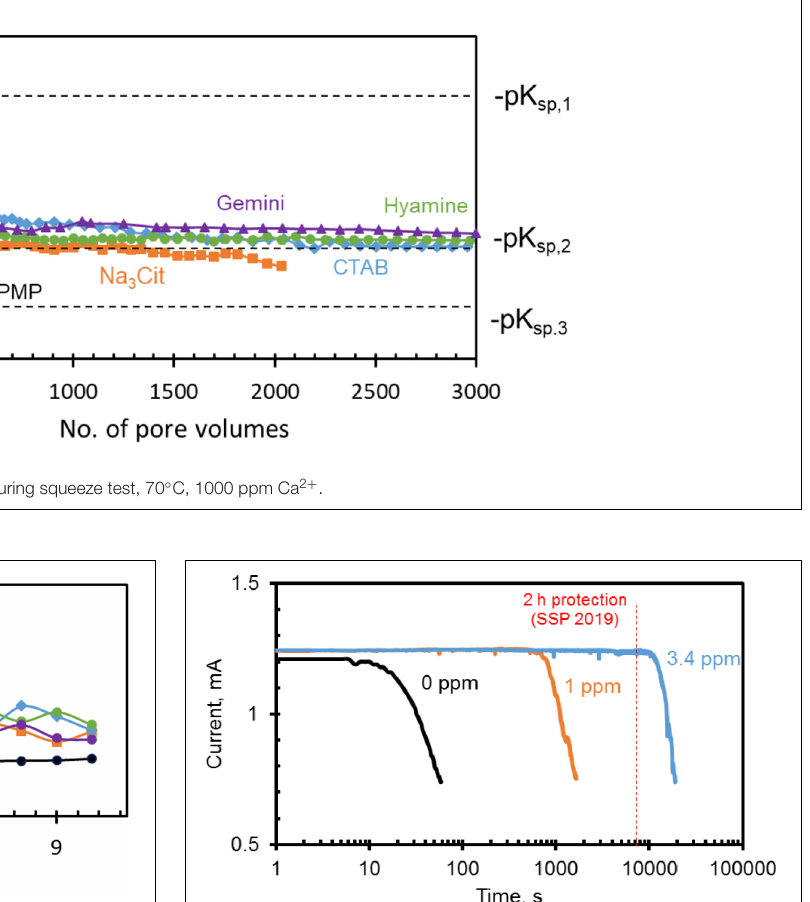
FIGURE 12 | Induction time measurement for the squeeze returned Gemini–Ca-DTPMP inhibitor, 70 ◦ C, DTPMP, 1 M NaCl, pH 5.1, SI(BaSO 4 ) =